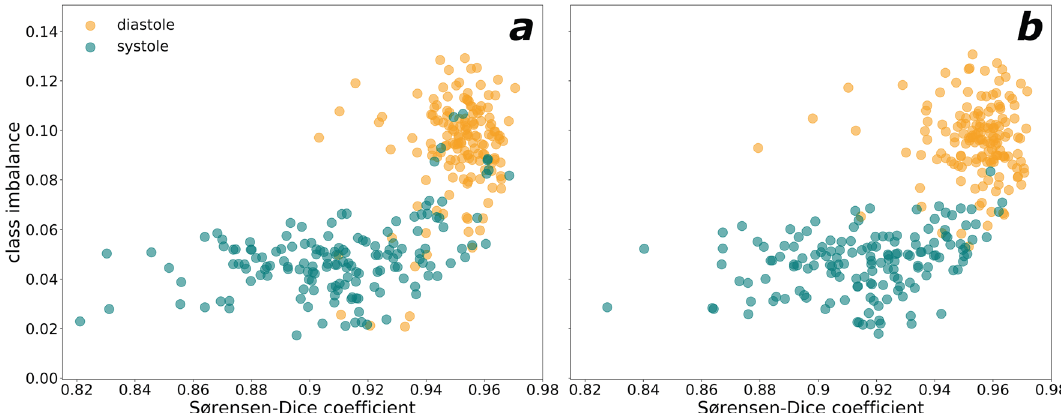
Figure 8. Class imbalance (foreground/background) vs Sørensen-Dice coefficient for systole and diastole phases for pooled Study 5 and Study 6 images with trained V-Net and Attention U-Net from 2MSA ( a ) and U-Net from 1MSA ( b